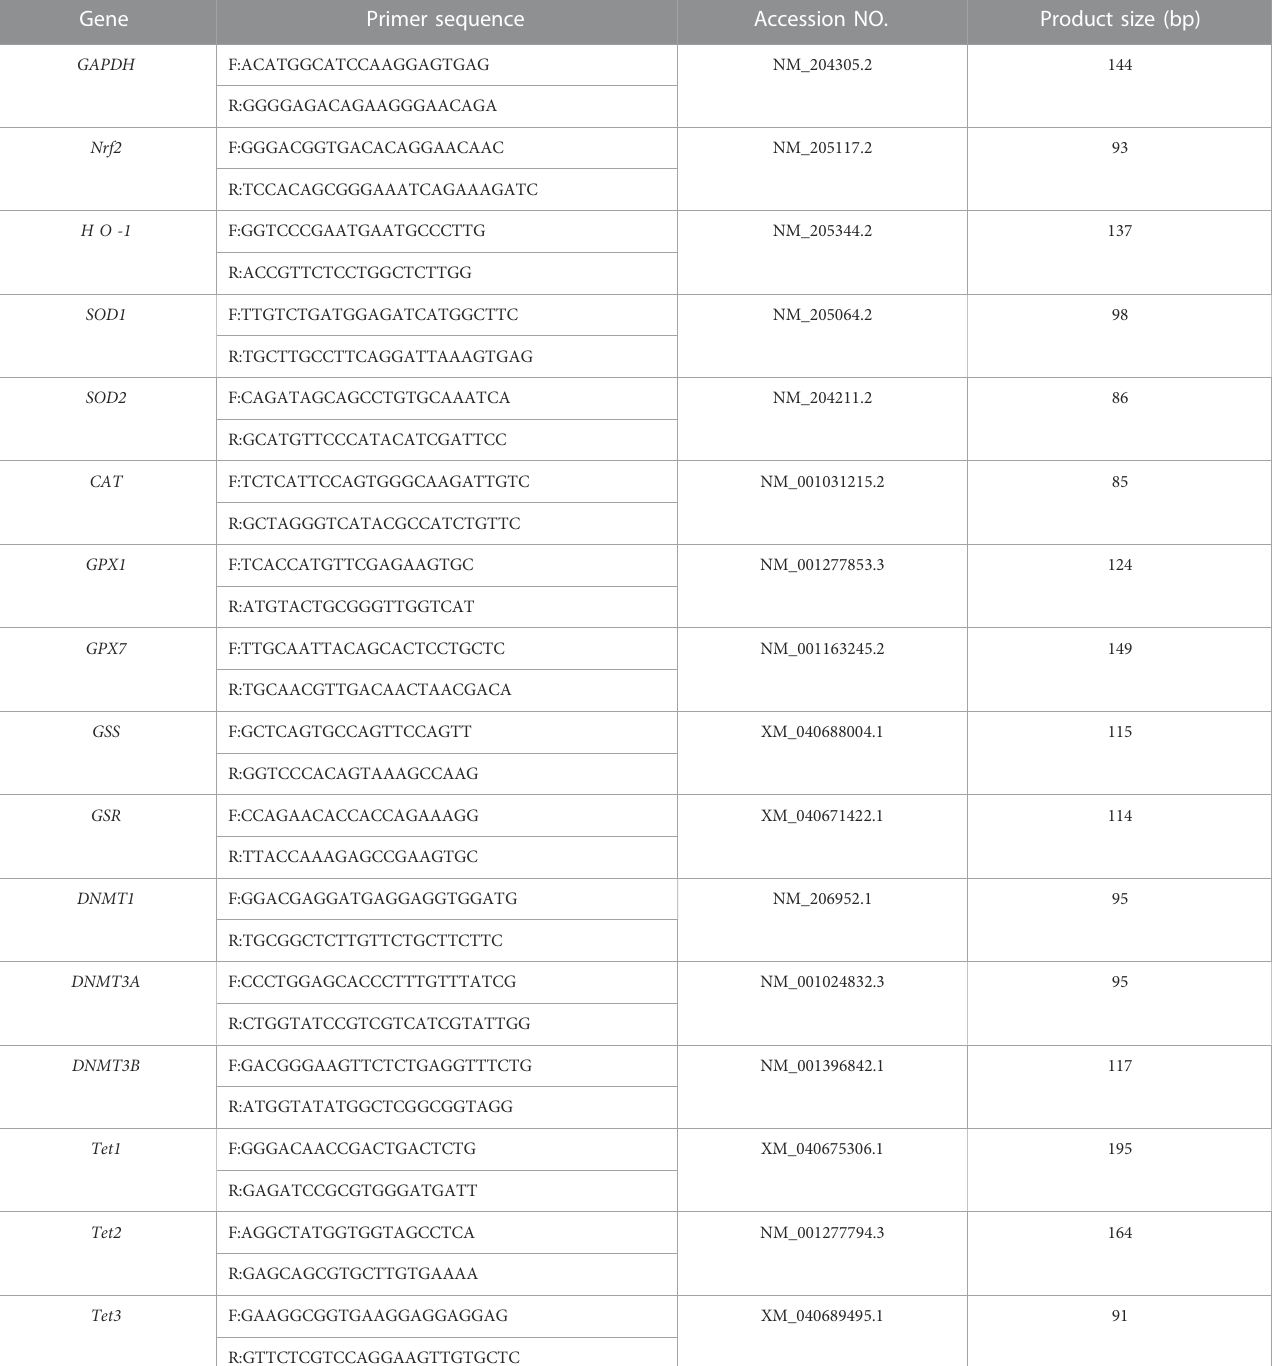
TABLE 1 Gene-speci fi c primer of related genes. Gene Primer